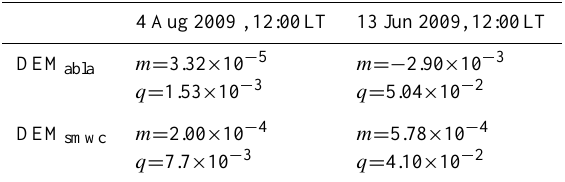
Table 3. Sensitivity to errors in the Digital Elevation Model. DEM abla is based on the original DEM for which all cells located in the ablation area of the glacier (below the equilibrium line) were lowered by 4m. DEM smwc is based on the original DEM and includes six surface melt water channels in the lower part of the glacier (width 10m, length ≈ 1km and depth 2m). The table reads mean m and root mean square deviation q for the difference in albedo retrieved based on the original and the modified